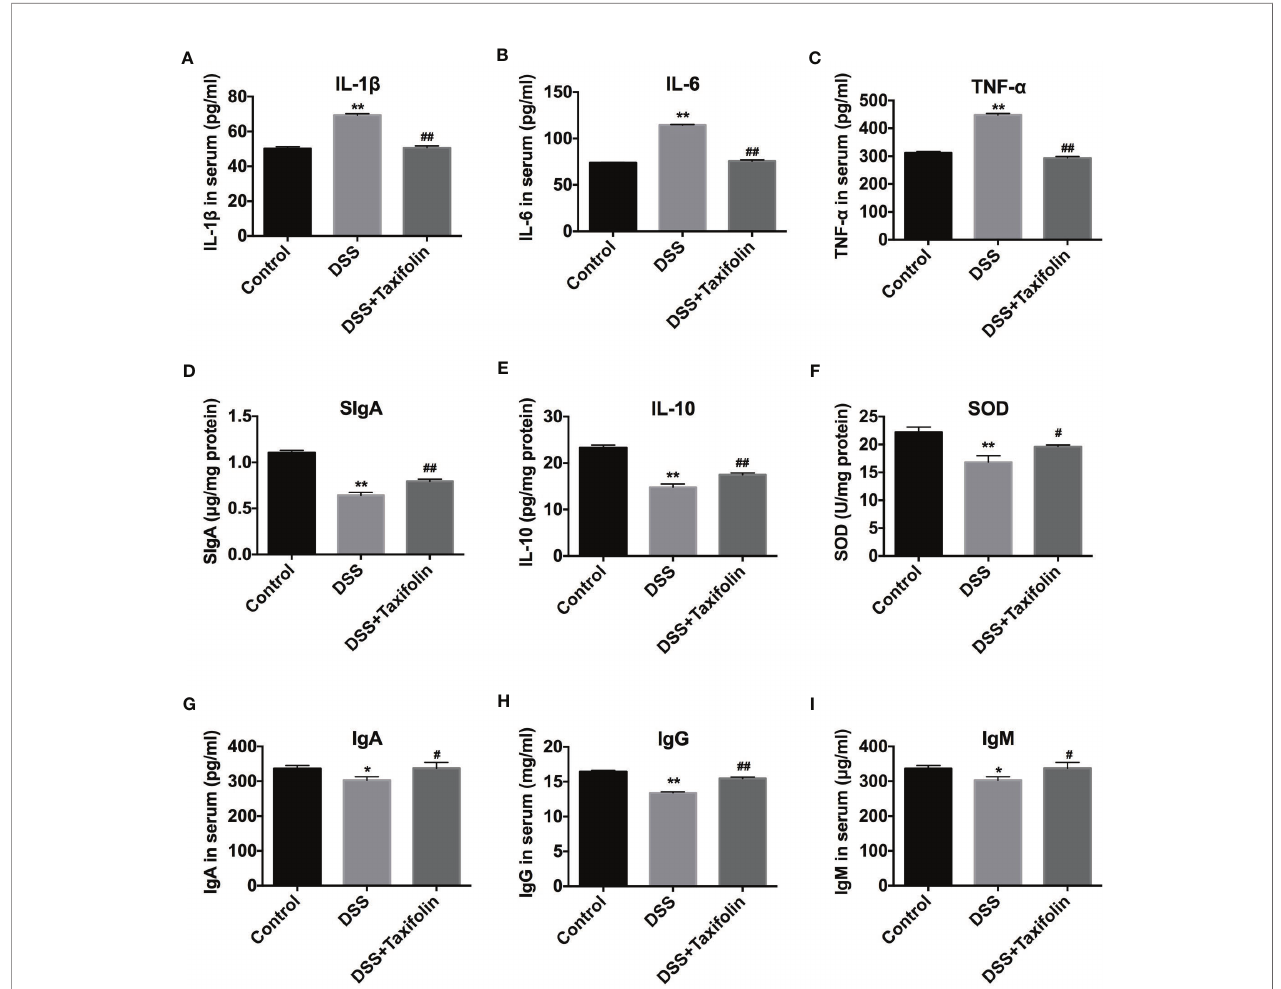
FIGURE 3 | Taxifolin decreased the content of pro-in fl ammatory cytokines and increased anti-in fl ammatory cytokines and immunoglobulins of DSS-challenged mice. (A – C) The concentrations of IL-1 b , IL-6, and TNF- a in serum; (D – F) Concentrations of SIgA, IL-10, and SOD in colon tissue; (G – I) Concentrations of IgA, IgG, and IgM in serum. Data were expressed as means ± SEM ( n = 10). * P < 0.05 and ** P < 0.01 vs . control group; # P < 0.05 and ## P < 0.01 vs . DSS